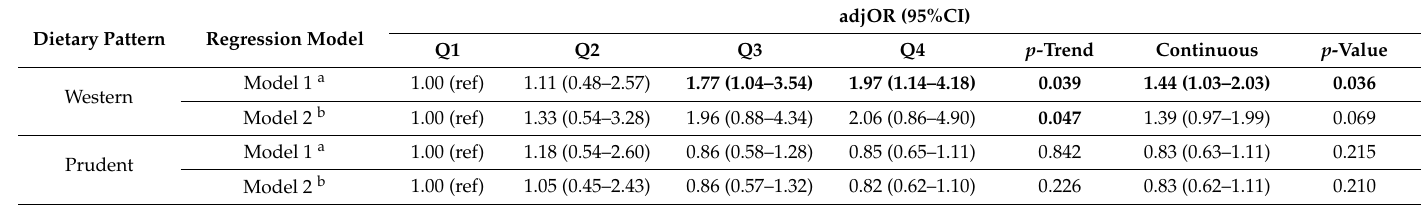
Table 4. Associations between dietary patterns derived by principal component analysis and the risk of hrHPV infection.